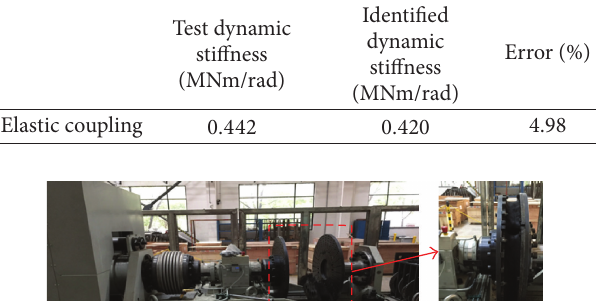
Table6:Comparisonofthedynamicstiffnessoftheelasticcoupling.